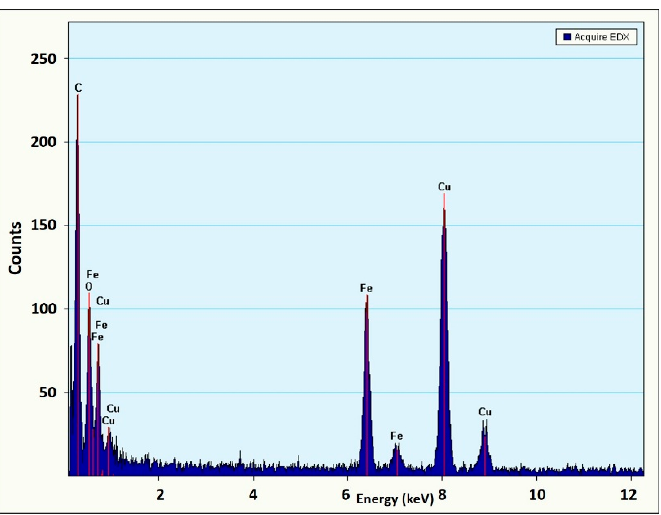
Figure 11. Histogram representing the distribution of the magnetite nanoparticles, as synthesized from the mill scale waste. 3.4. Magnetic and Surface Properties Investigations The magnetic properties of ION are the key factor in the use of nanomaterials as sorbents for water and wastewater treatment of heavy metal ions [50]. Adding magnetic properties to nanoparticles allows for nanoadsorbents to be magnetically separated. Our research group developed a solenoid column for the removal of heavy metal ions using magnetic nanoparticles [51]. Therefore, the magnetic properties of ION nano-powders are as important as their adsorption properties for water treatment applications. Figure 12 presents the magnetization curve function of the magnetic field strength, H, measured in the range of 𝐻 ∈ (cid:4670)−10,000, +10,000(cid:4671) Gauss. Because the hysteresis curve area is null, the ION nanoparticles exhibit superparamagnetic behavior at room tempera- ture. Additionally, the shape of the magnetization curve indicates the nanomaterial char- acteristics of the powder.